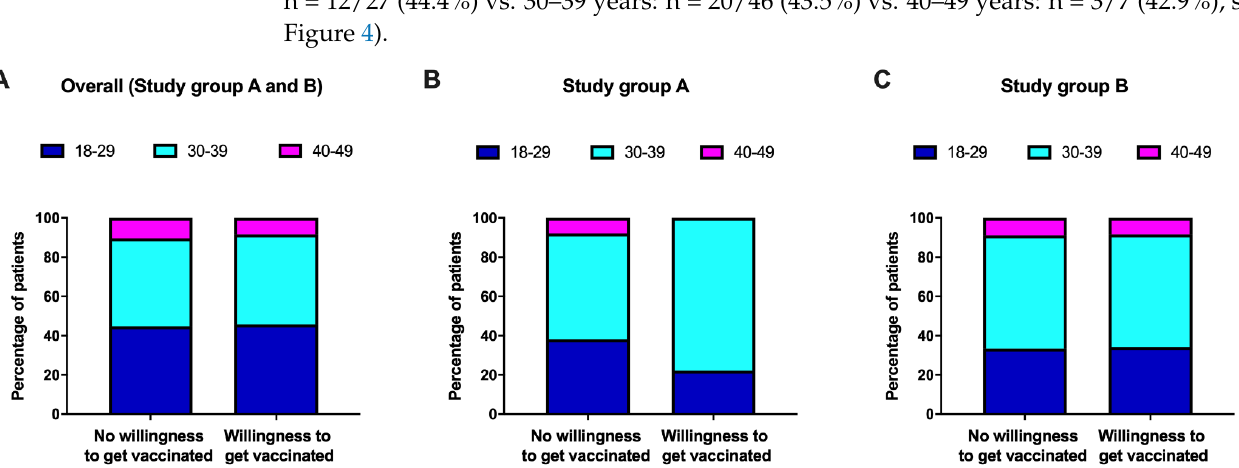
Figure 4. Stratification of the patients in different age groups of ( A ) the overall study group collec- tive (i.e., study group A and B), ( B ) study group A and ( C ) study group B. There was no difference between age groups in the overall study group collective or study group B. In study group A (writ- ten briefing only), the group of women aged 40 – 49 showed no interest in receiving or planning to receive the SARS-CoV-2 vaccination.